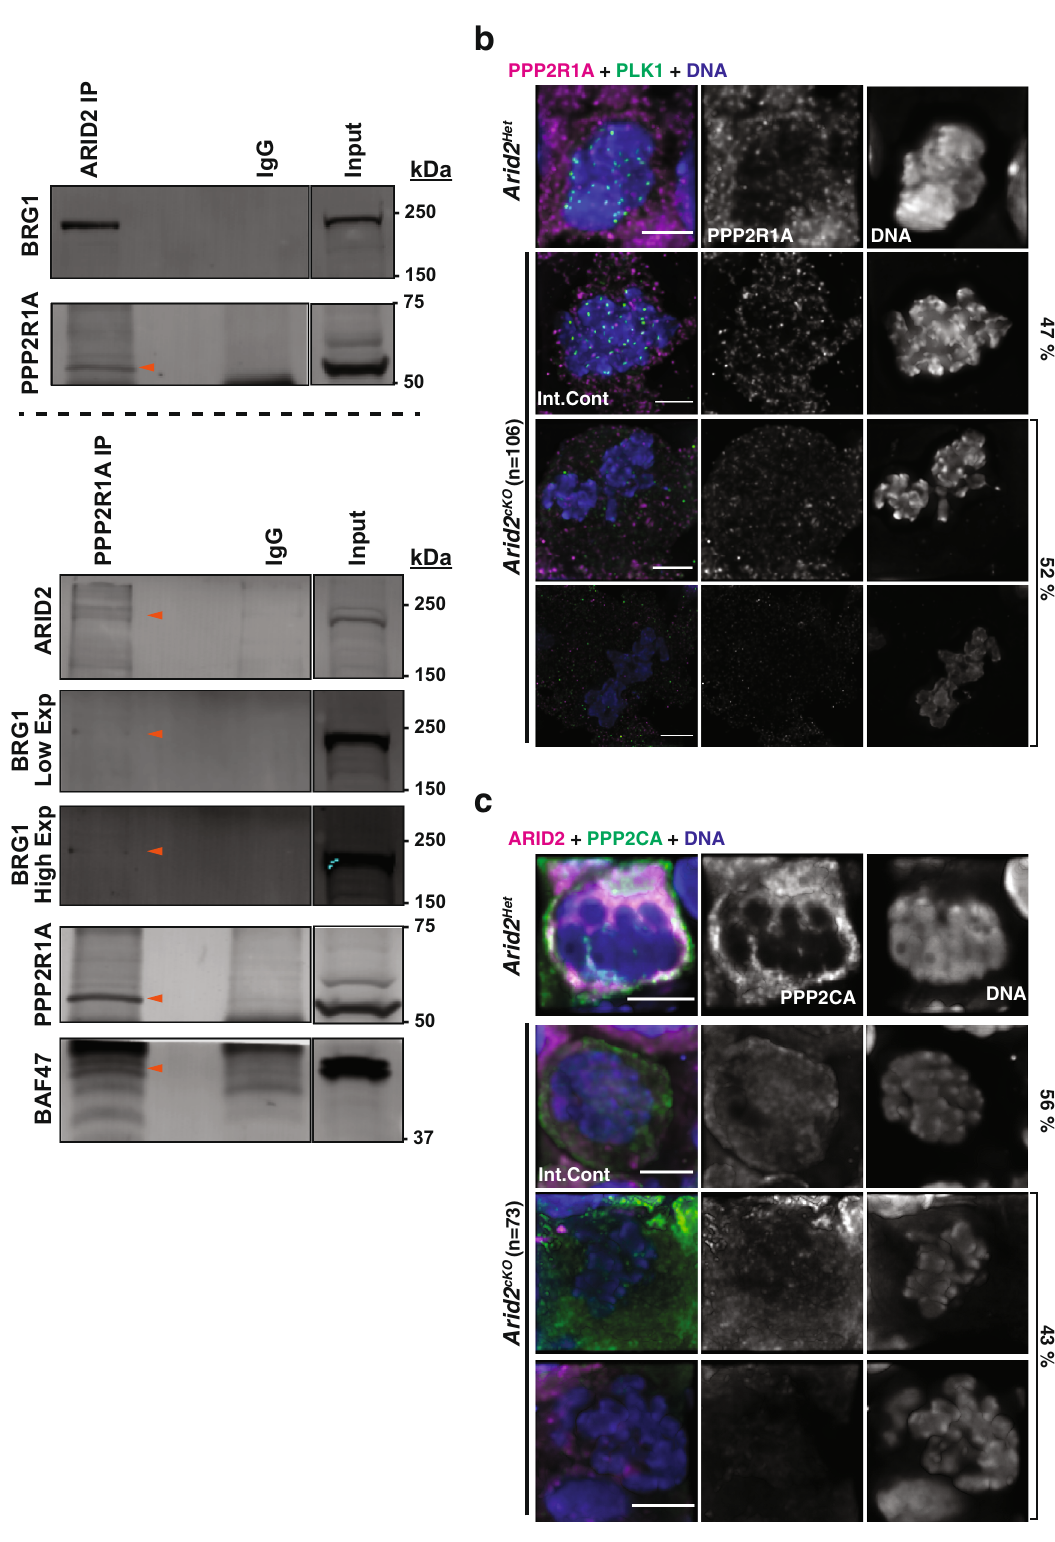
Fig. 8 The in fl uence of ARID2 on PP2A stability. a ARID2 (top) and PPP2R1A (bottom) Co-IPs. Immunoblotted proteins are labeled with orange arrowheads. Data were representative of Co-IPs reproducibly repeated twice. b , c Arid2 Het and Arid2 cKO metaphase-I spermatocytes immunolabelled for b PPP2R1A (magenta) and PLK1 (green), c ARID2 (magenta) and PPP2CA (green). Scale bar: 5 μ m, magni fi cation: 100.8x. The number of metaphase-I spermatocytes scored ( n ) and their proportion (%) in Arid2 cKO seminiferous tubules are